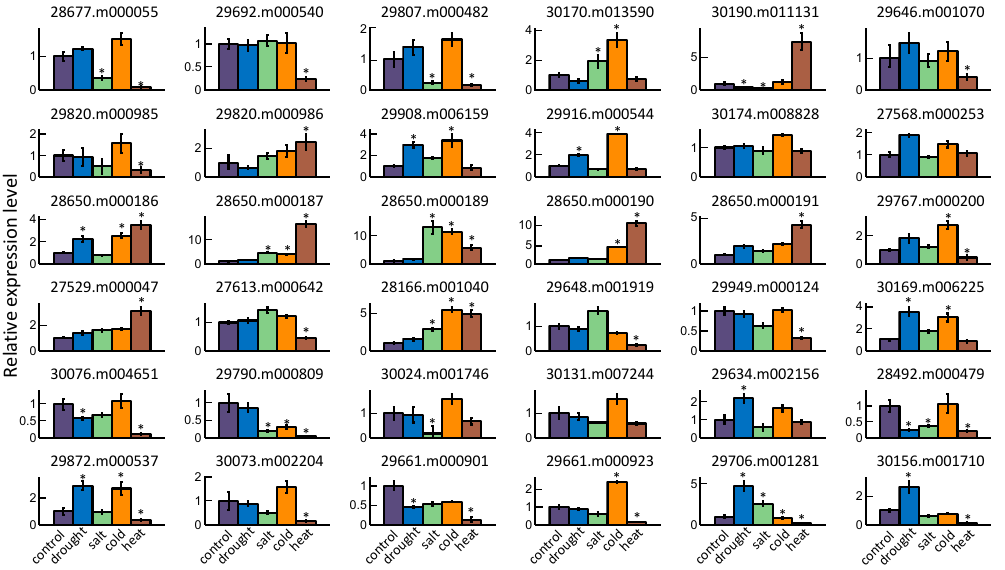
Figure 6. Relative expression levels of 36 GRAS genes in different abiotic stress treatments. The two-week-old castor bean seedlings were subjected to various stress treatments including drought, salt, cold, and heat. The columns represent the expression levels of a gene, and the error bars show the standard error with three biological replicates. The expression level of control sample was normalized to 1. The asterisk above the columns indicates a significant change of expression level between stress treatment and control at p < 0.05.